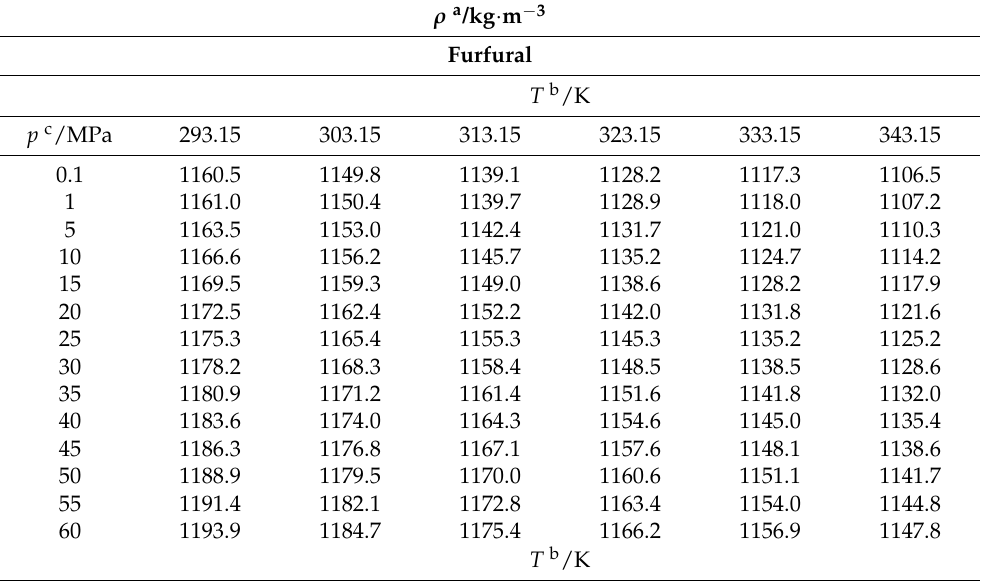
Table 4. Density, ρ , of the pure furfural and furfuryl alcohol at temperatures (293.15–413.15) K and pressures up to 60